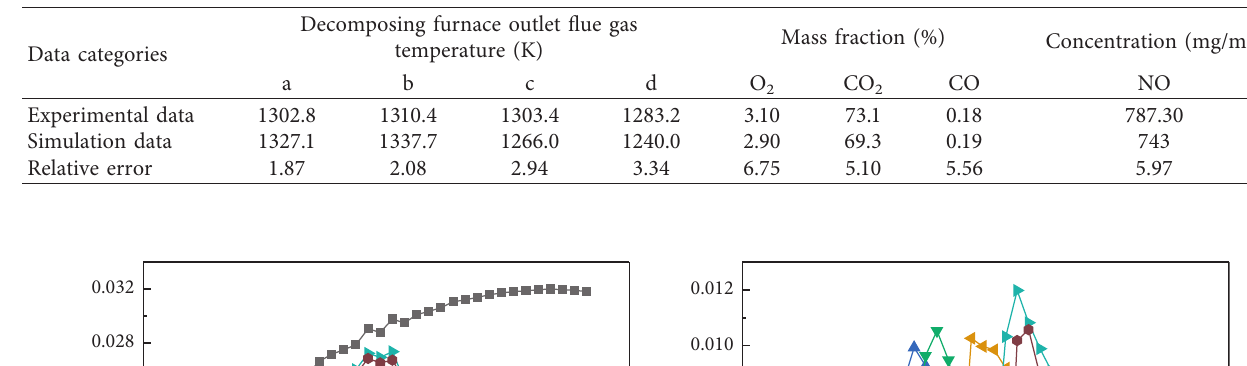
Table 4: Comparison of the measured data and simulated data.